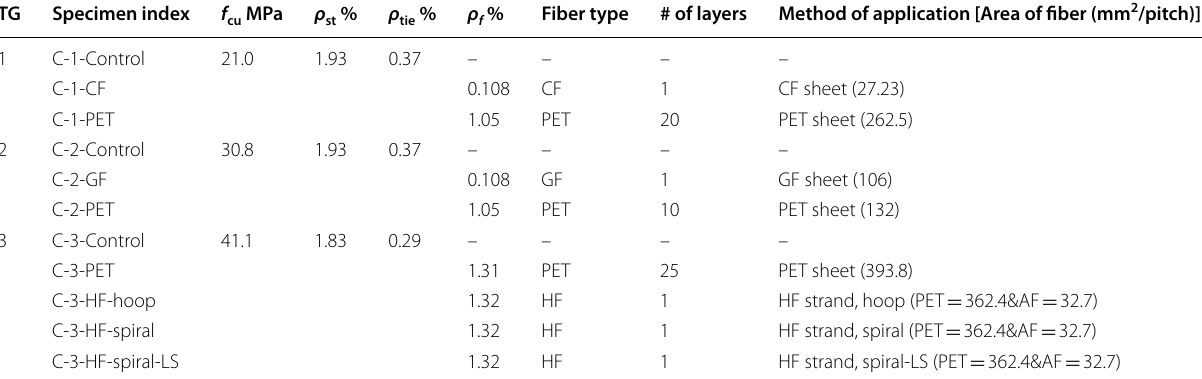
LS is lap-splice (equal to 1.3 times development length); f cu is compressive strength of concrete at 56 days; ρ st is steel reinforcement ratio ( A st / A g ); A st is area of steel; A g is gross area of specimen; ρ tie ; tie reinforcement ratio ( V tie / V core_con ); V tie is volume of column tie; V core_con is volume of core concrete; ρ f = ( V f / V core_con ); V f is volume of fiber ( area of fiber (mm 2 /pitch) perimeter pitch (1 pitch is 250 mm and 300 mm for TG-1 & TG-2 and TG-3, respectively; shear span( a ) = × × is 1,200 mm and 1250 mm for TG-1&TG-2 and TG-3, respectively; effective depth ( d ) is 352 mm for all columns; a/d column diameter 400 mm and column height 1500 mm for all columns. = = Table 3 Mechanical properties of deformed steel reinforcement